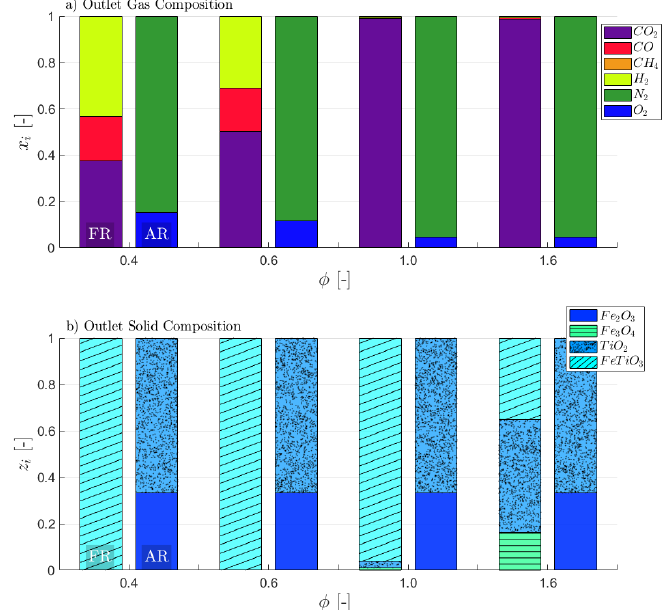
Figure 4. Simulation results for CLG operation through reduced oxygen carrier (OC) circulation. Dry molar gas composition ( a ) and molar solid composition ( b ) as a function of 𝜙 for varying OC circulation rates ( 𝜆 = 1.2).